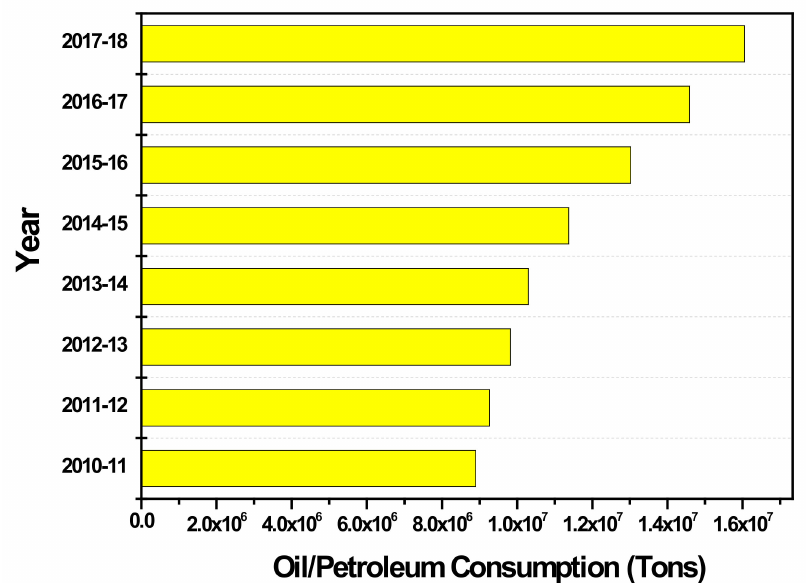
Figure 7. Consumption of oil/petroleum by transport in Pakistan [5].